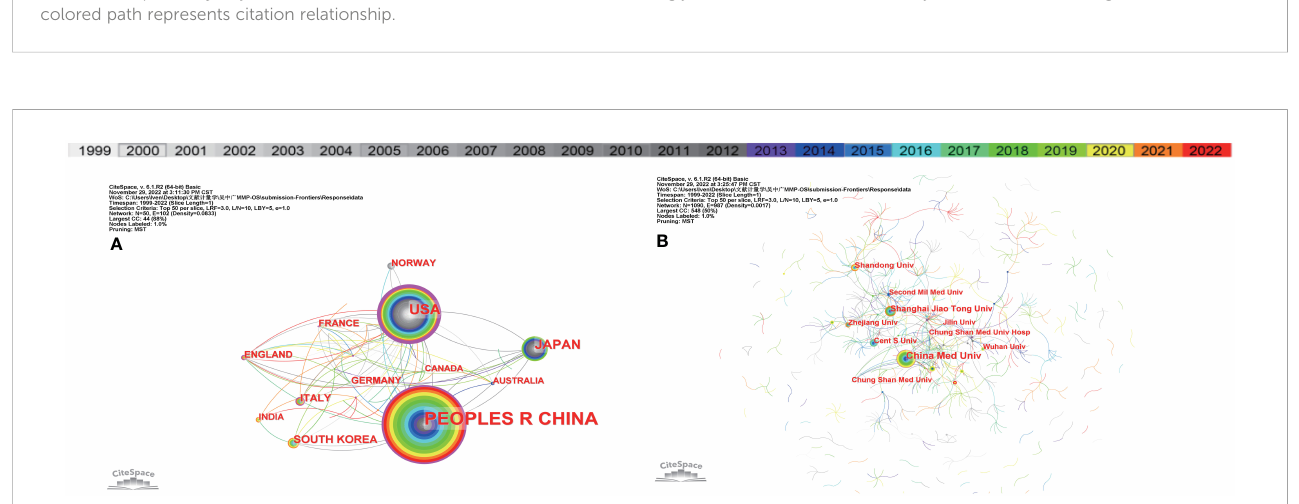
FIGURE 4 The co-occurrence map of (A) countries/regions and (B) institutions in MMP-OS research (T ≥ 19). The size of node re fl ects the co-occurrence frequencies, and the links indicate the co-occurrence relationships. The color of node and line represents different years, colors vary from purple to red as time goes from1999 to 2022; and node with purple round means high betweenness centrality